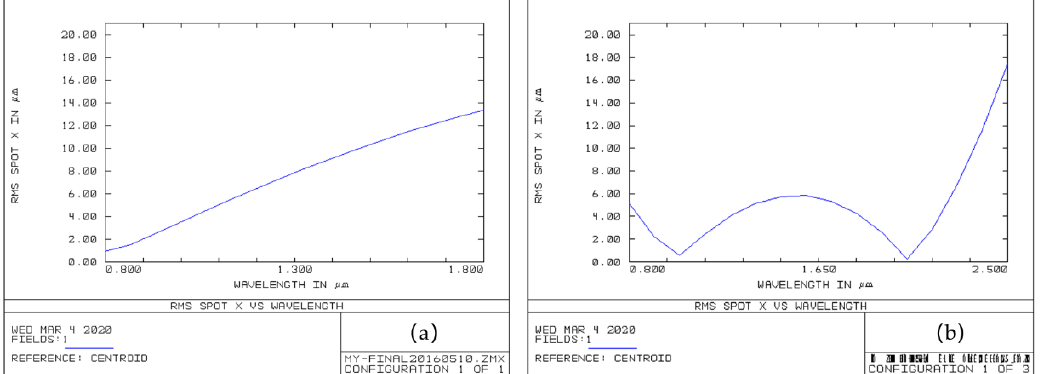
Figure 3. ( a ) The root mean square (RMS) spot x of the previous optical structure; ( b ) the RMS spot x of the modified crossed Czerny–Turner optical design.